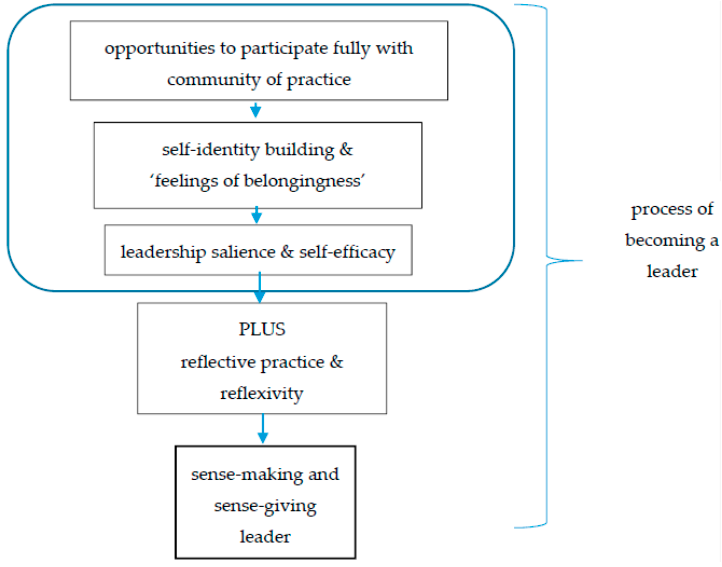
Figure 1. Process of becoming a leader (adapted from Kempster [4]).